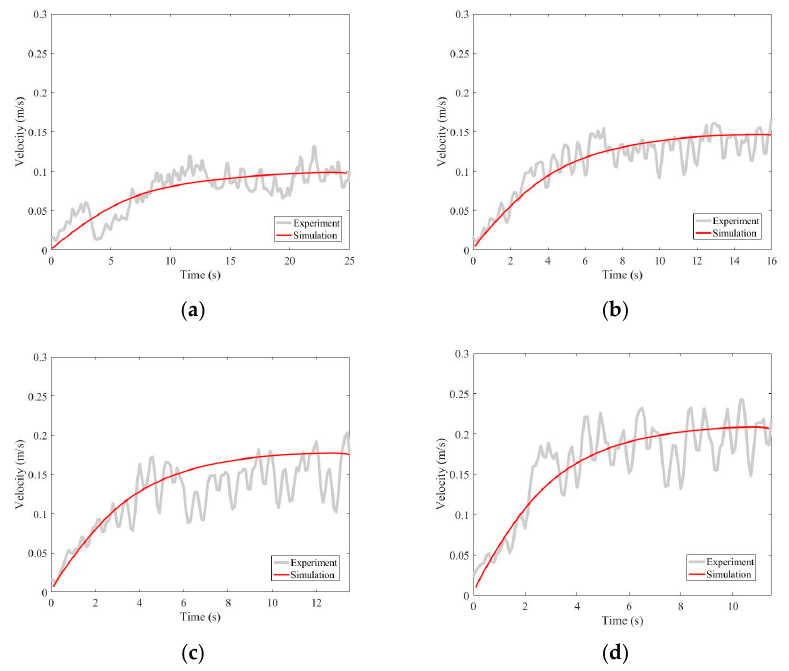
Figure 11. The comparison of experiments and simulations on force–velocity relationships. ( a ) Thrust 0.37 N; ( b ) Thrust 0.91 N; ( c ) Thrust 1.36 N; ( d ) Thrust 1.91 N.